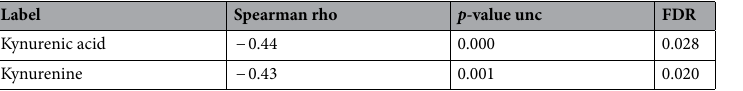
Table 4. Correlation between reduction in Hamilton Rating Scale for Depression (HRSD) and plasma